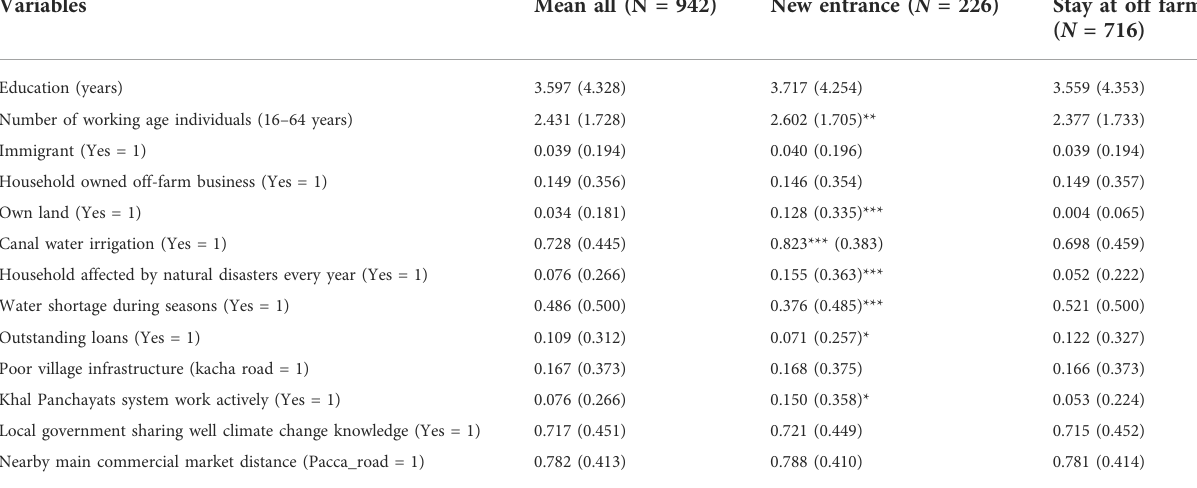
TABLE 5 Variables, de fi nitions, means, and difference-in-means